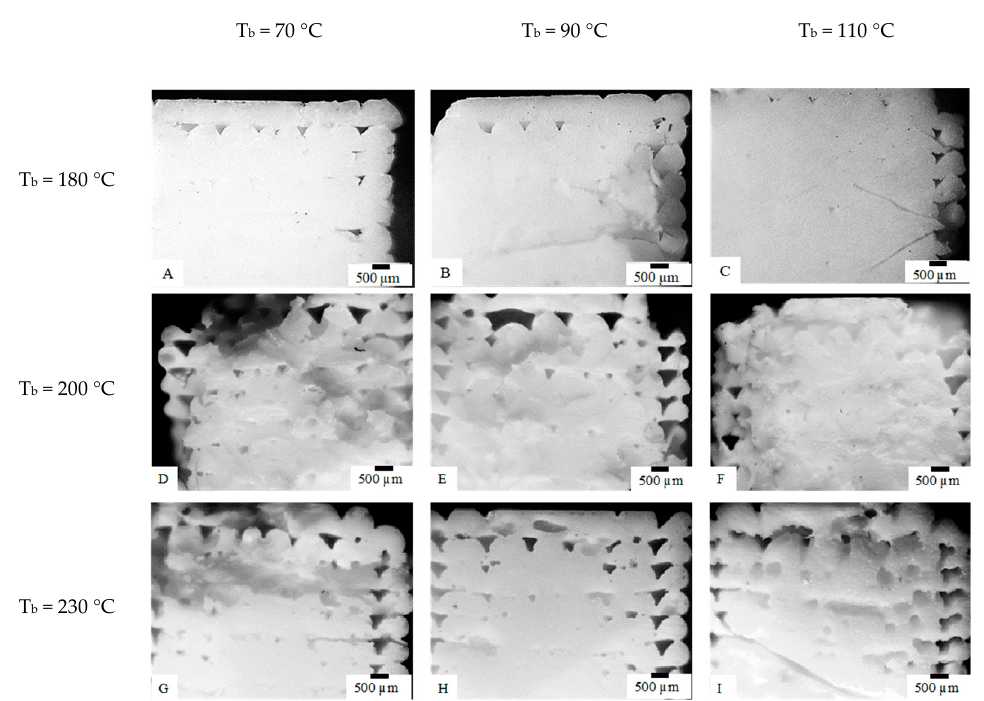
Figure 6. Optical micrographs of the specimens obtained at different T n and T b . The part of the specimen farer from the deposition plate has been shown. T n and T b have been also indicated in the figure (see Table 1 for operative conditions). 1.244 Figure 7. Bulk density of the specimens obtained with different T n and T b . Figure 8 shows the stress–strain plots obtained for the specimens produced with different nozzle and plate deposition temperatures. Table 3 summarizes the results ob- tained from the tensile analyses. 1.226 1.2281.2301.232 1.234 1.2361.2381.240 1.242